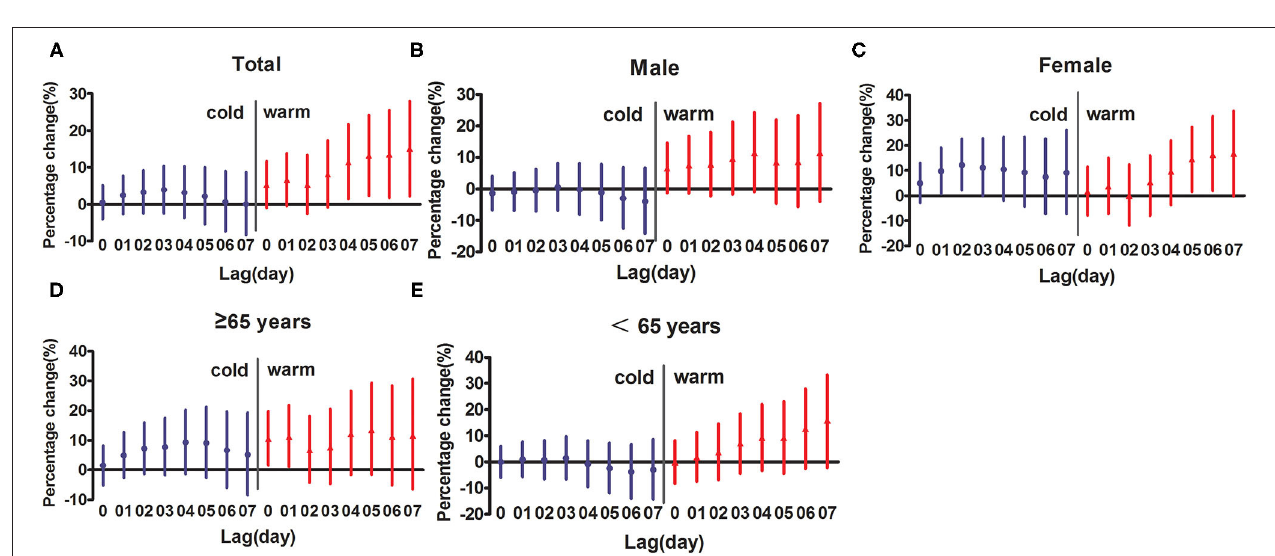
FIGURE 1 | Relative risk (RR) of respiratory inpatient visits caused by different SO 2 concentrations.